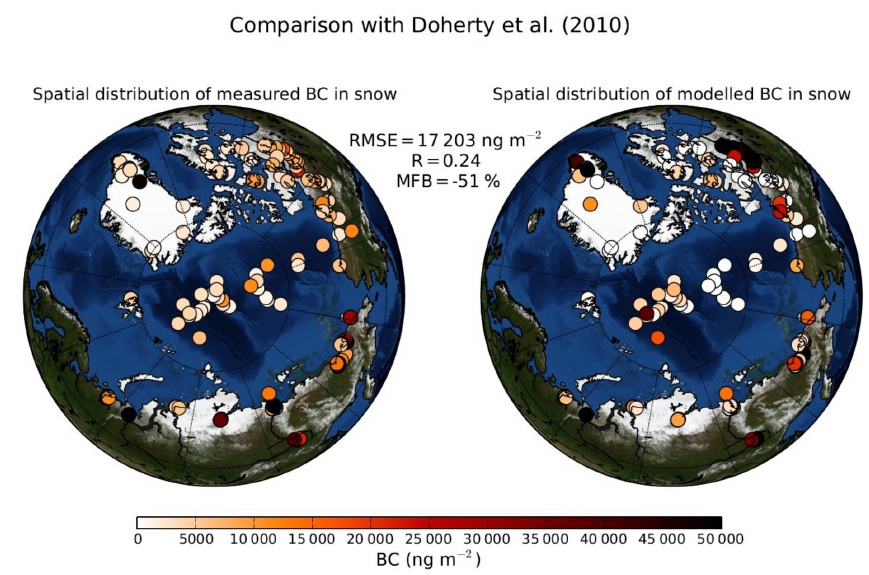
Figure 8. Measured and modelled BC concentration in snow. (The background shows the blue marble image, source: MODIS, NASA Earth